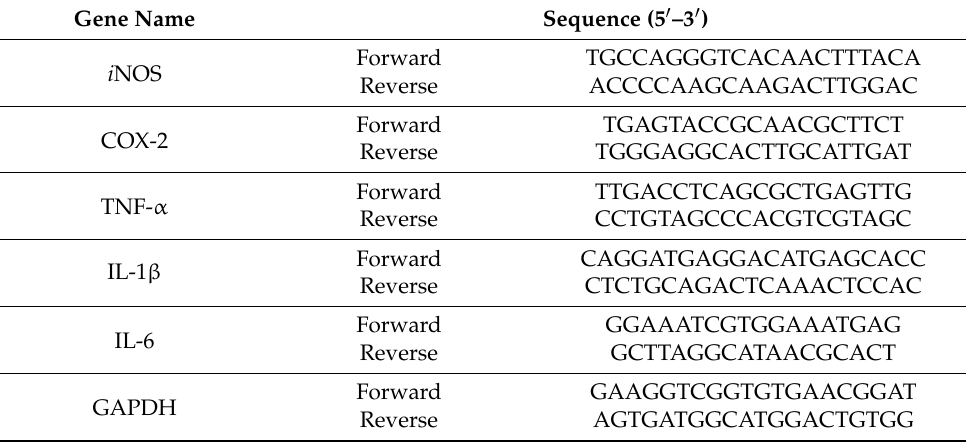
Table 3. Sequences of primers used for semiquantitative RT-PCR analysis.